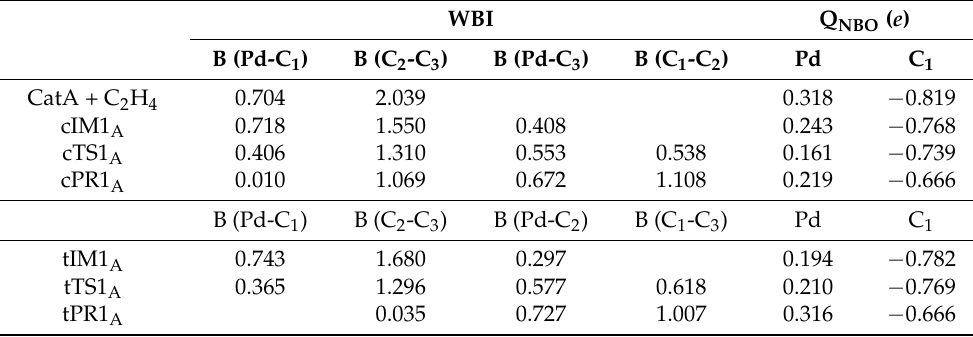
Table 1. The Wiberg bond indices (WBIs) and natural charges (Q NBO ) for some key bonds and atoms of the reaction pathway for the first ethylene insertion.